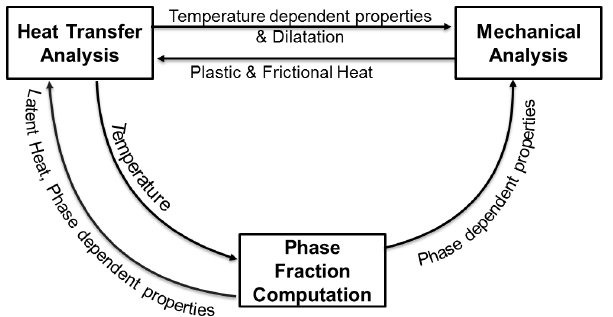
Figure 7. Coupling of thermomechanical–microstructural fields.